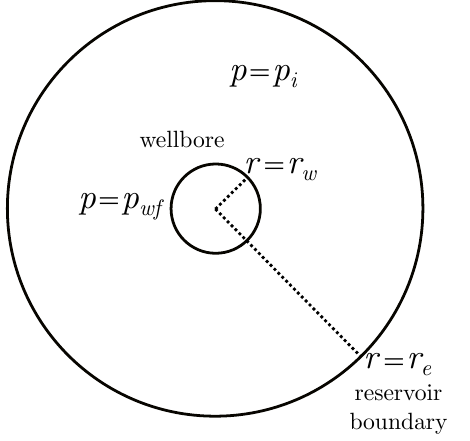
Figure A1. A simple model of radial flow—constant pressure—bounded